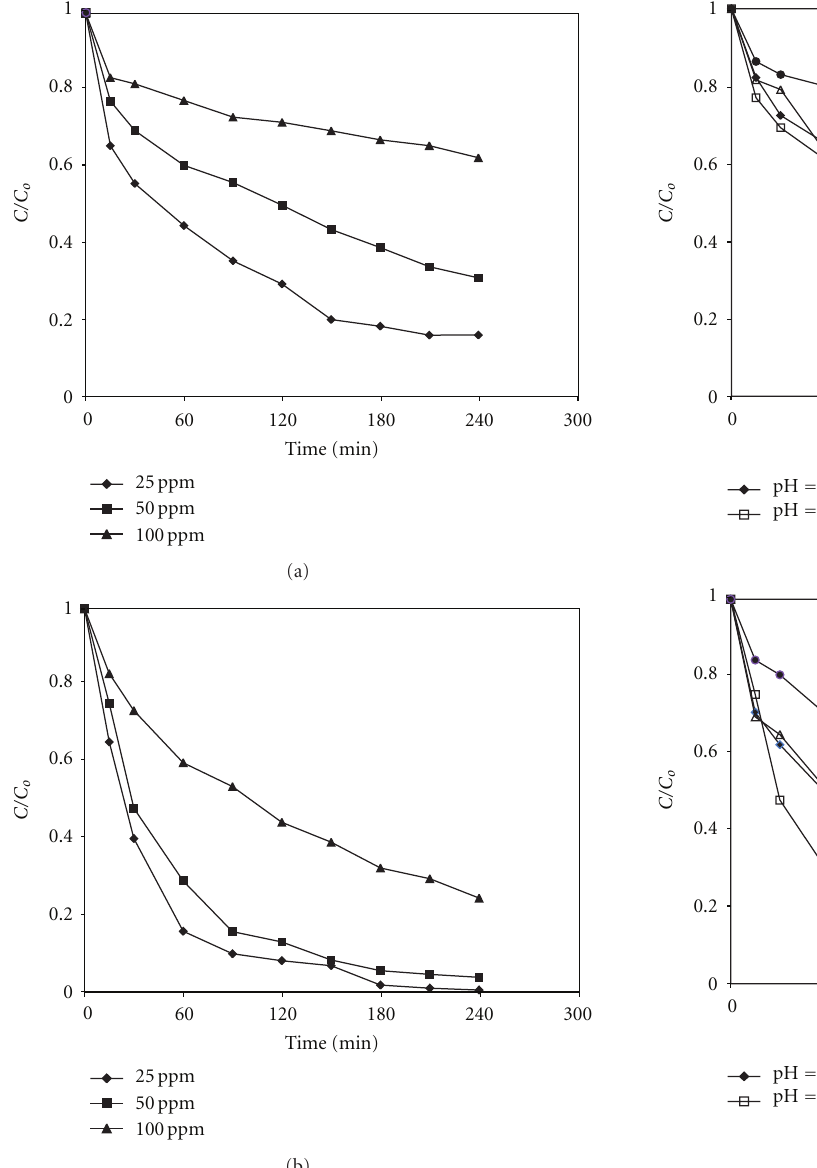
Figure 12: E ff ect of initial pH on photocatalytic degradation (a) phenol (b) o-